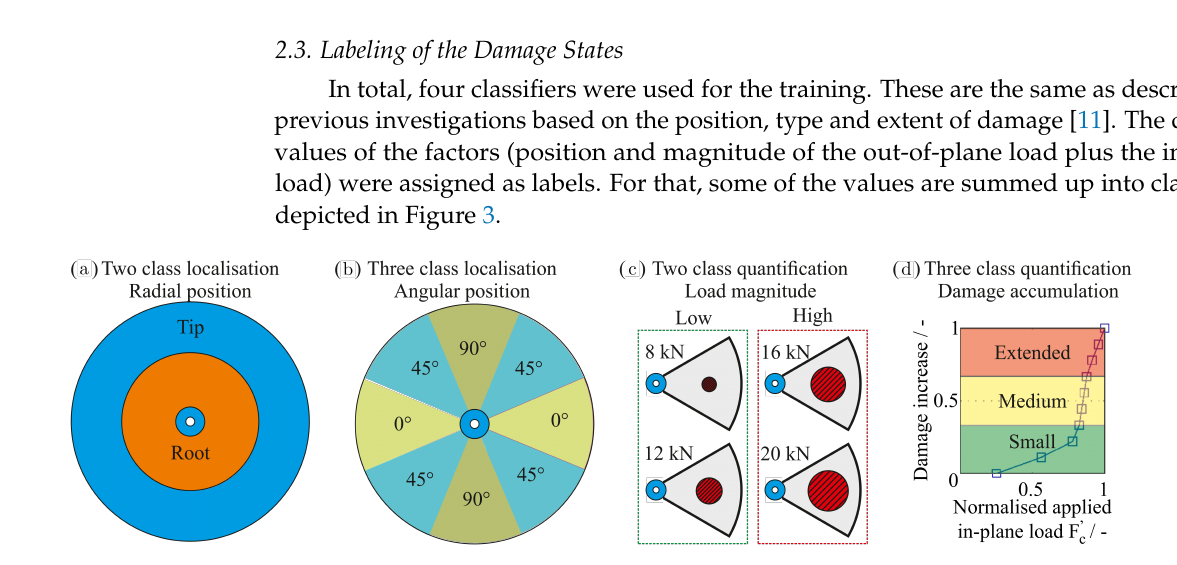
Figure 3. The four physical-based classifiers and their labels. ( a ) shows the radial position, ( b ) the angular position and ( c ) the load magnitude that describes the out-of-plane load. The out-of-plane load with damage accumulation is shown in ( d ) [11]. The first classifier referred to as the radial position (RAD) is described by two classes: